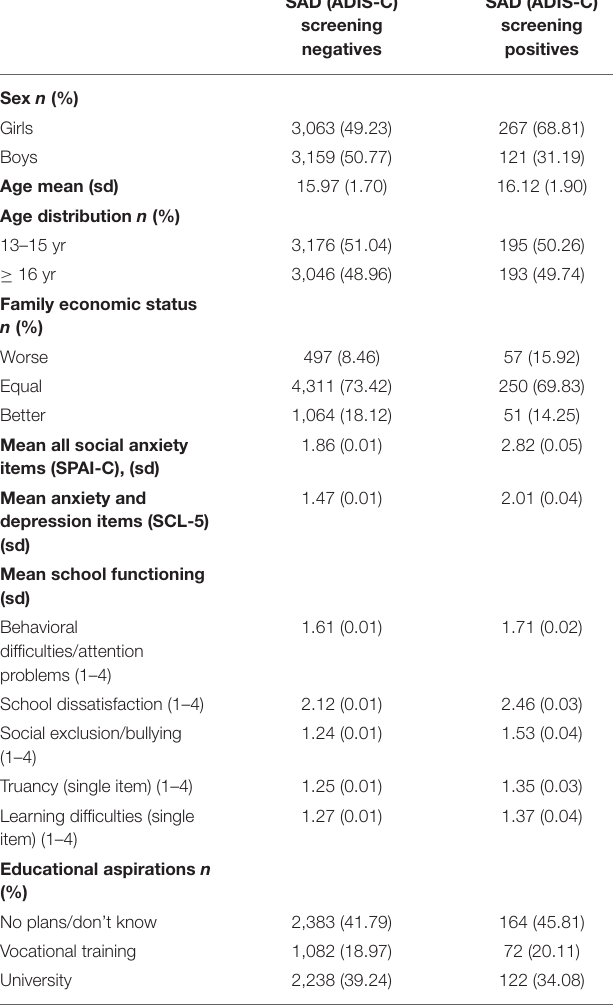
TABLE 1 | Descriptive characteristics of adolescents in Young-HUNT3 categorized/identified as ADIS-C screening negative ( n = 6,222) and ADIS-C screening positive ( n =